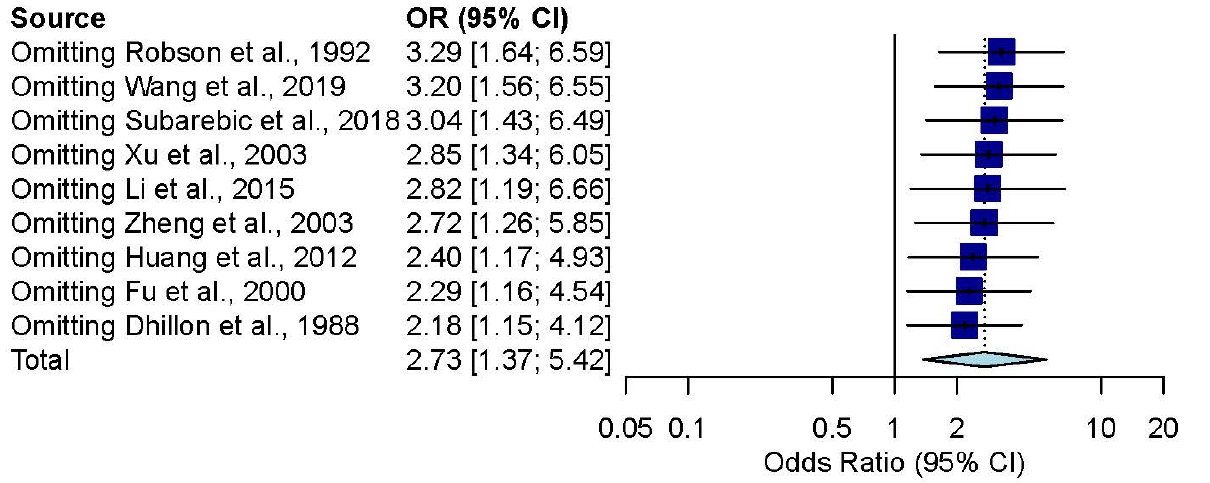
Figure 5. Influence analysis of the overall effect of palatal repair with VTI.